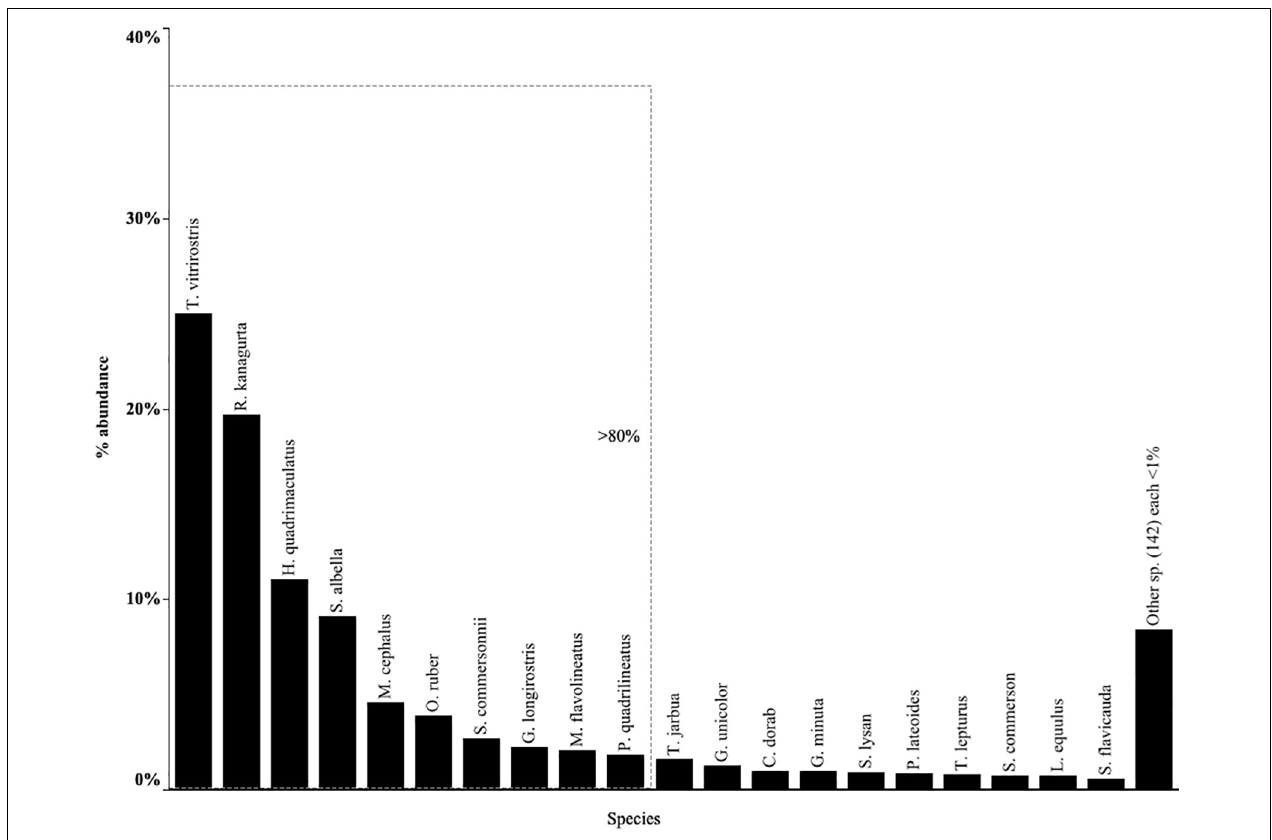
FIGURE 3 | Relative abundance of top 20 species with the top 10 contributing more than 80% of the total abundance. Top species for each gear type given in Supplementary Figure S1 and a full species list and relative abundances by each gear type given in Supplementary Table S2 .